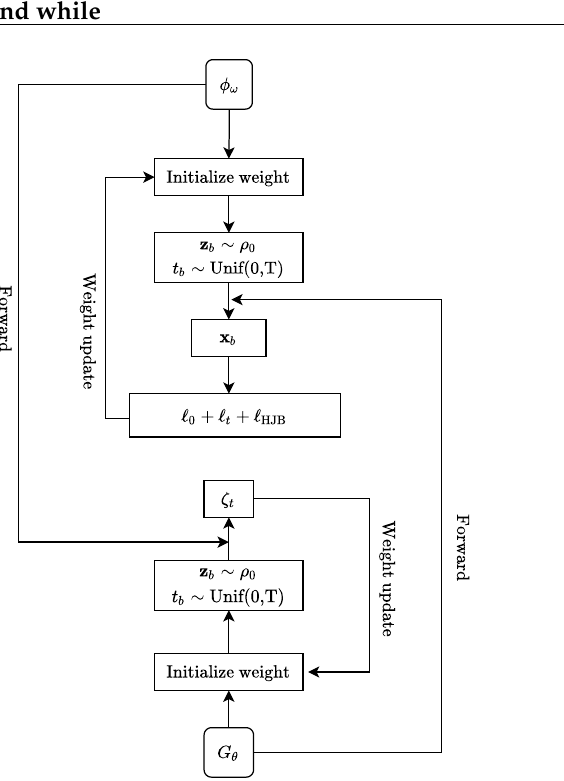
Figure 1. Visualization of the structure and training process of our GAN-based neural network. Its training process is divided into two coupled alternating training parts—generator and